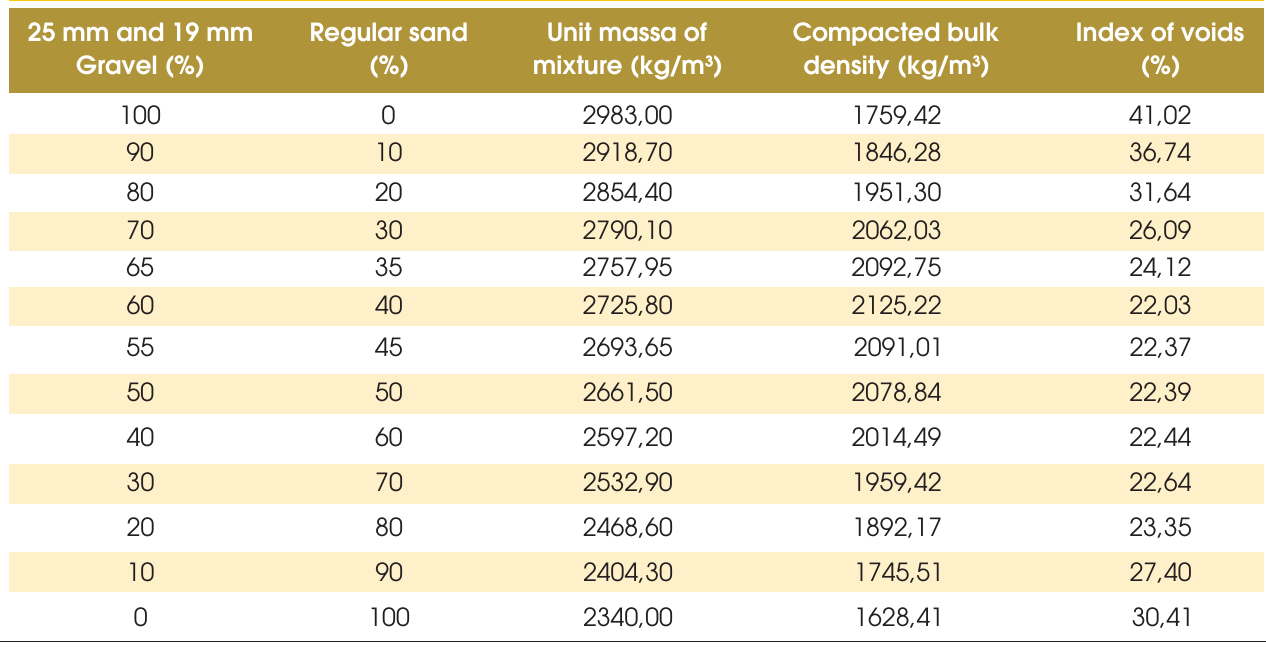
Table 3 – packing test between 25 mm gravel and 19 mm gravel and the regular